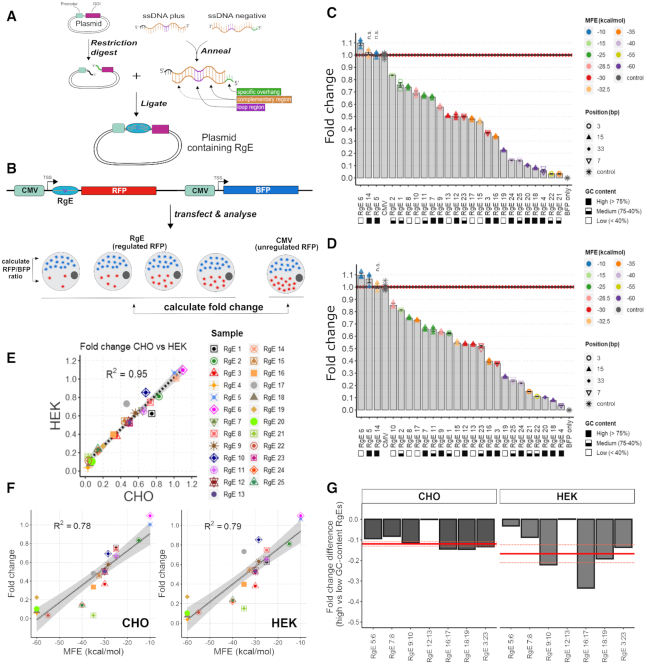
Proof-of-principle and evaluation of RgEs in mammalian cell lines. (A) Cloning procedure of RgE insertion into 5′-UTRs. GOI = gene of interest. (B) Schematic representation of experimental proof-of-principle. (C andD) Calculated fold change (FC) of RFP/BFP expression ratio mediated by RgEs screened in CHO (C) and HEK293 (D) cells in reference to the unregulated CMV sample. Bars show average, colored points show individual values of samples (n = 3 independent samples each; CMV: n = 6) and error bars show SEM. Color, shape and GC-content indicated on the right side. Elements are ordered according to their average fold change. The horizontal black line shows average, red dotted lines show SEM of CMV samples. All samples, except the ones marked with ‘n.s.’, showed a significant difference with P < 0.001 in comparison to the CMV sample. (E) Average fold changes of CHO versus HEK cells. Gray area shows standard error. (F) Average fold changes (FC) of CHO (left) and HEK (right) cell plotted against the MFE of the respective elements. Gray area as in (E). (G) Differences in fold change observed between high and low GC content elements of similar MFE at the same relative position. Y-axis depicts the calculated FC difference. X-axis shows the RgE pairs that were compared. Red full line shows averages (RgE 12:13 not included). Light red dotted line depicts SEM.